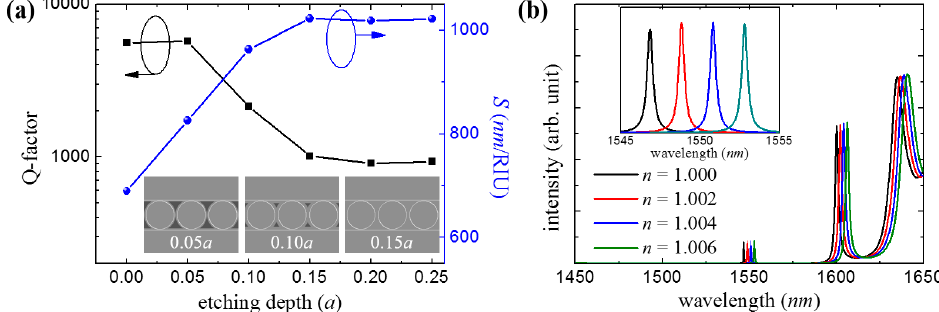
Figure 5. ( a ) The effect of the remaining sacrificial layer on the Q-factor and S of the air gap mode in 227